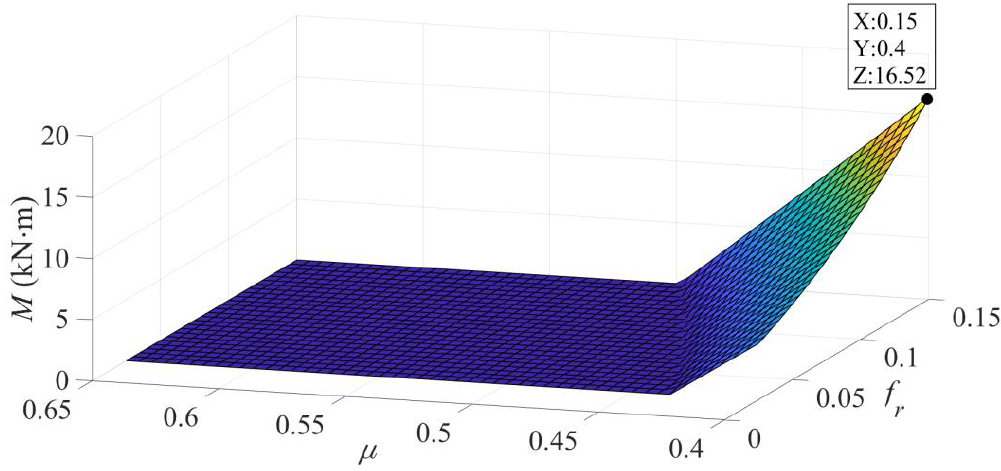
Figure 5. Torque on the steering arm with different rolling resistance coefficients and friction coefficients.